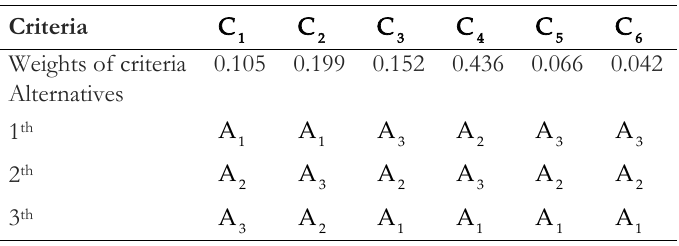
Table 13. Priority of each alternative in each criterion.